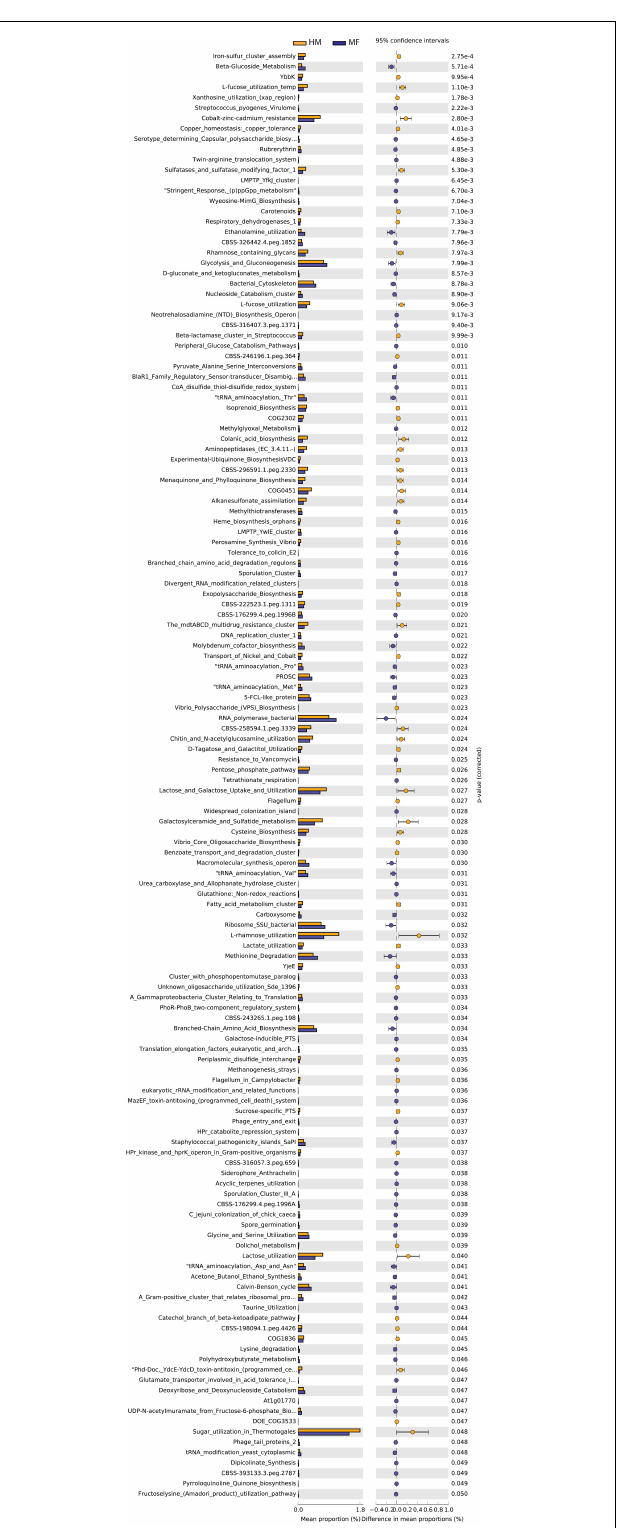
FIGURE 3 | Significant differences in predicted metabolic functions ( P < 0.05) for distal colon bacterial gene profile detected at PND 21 in male piglets fed with HM or MF from day 2 until day 21 of age.